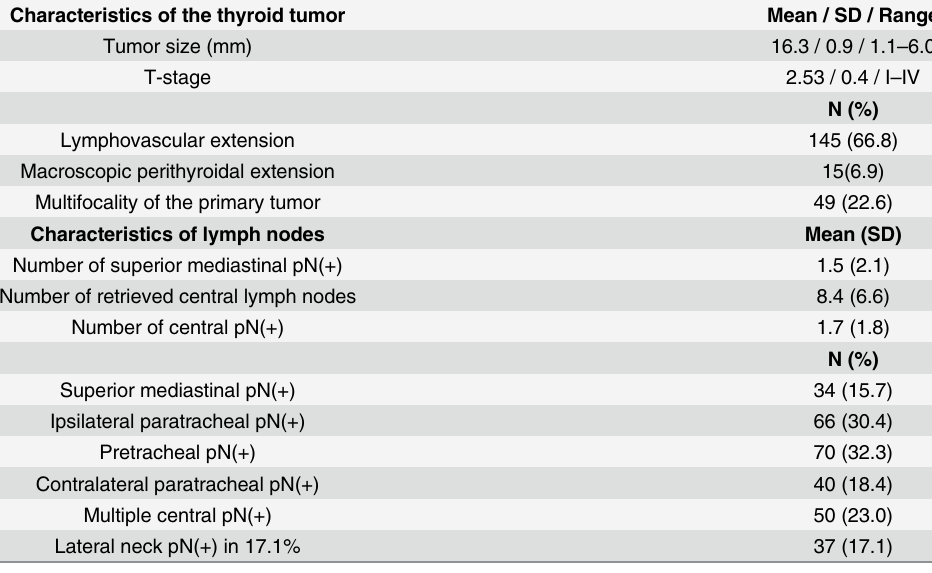
Table 2. Pathologic characteristics of thyroid carcinoma and lymph node metastasis. Characteristics of the thyroid